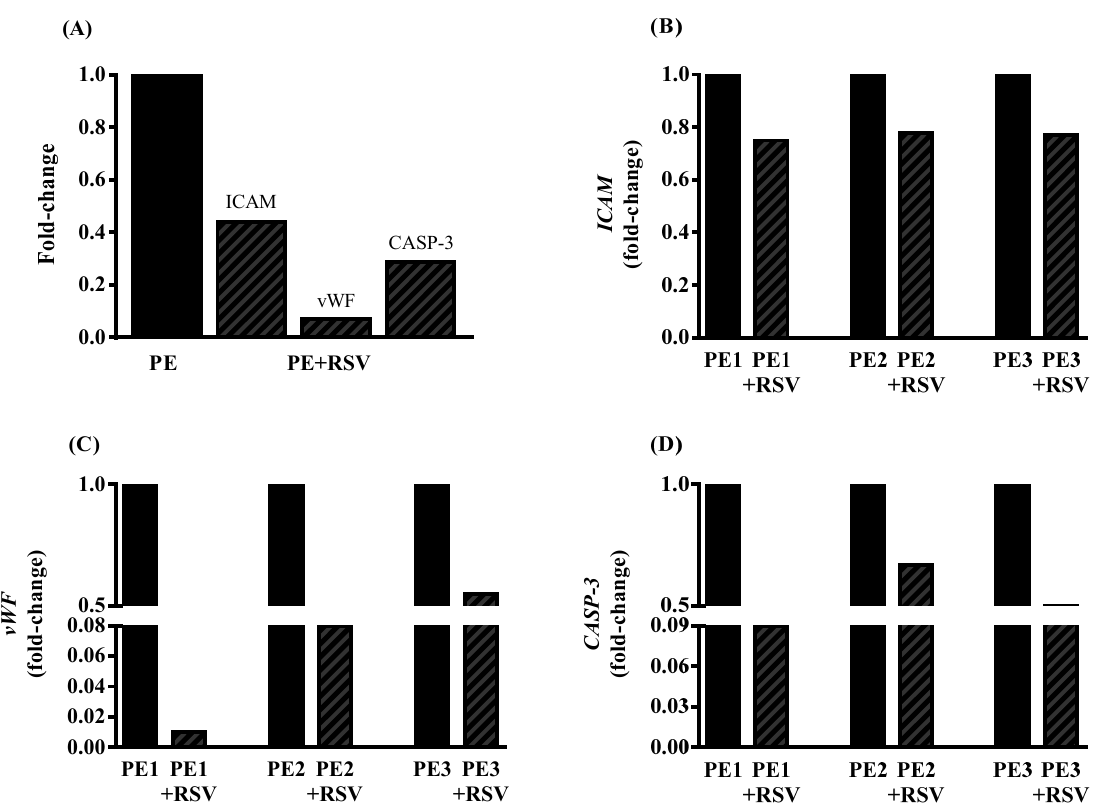
Figure 4. Fold change of ICAM-1 , vWF , and CASP-3 in all umbilical arteries tested ( A ), followed by independent gene expression in each preeclampsia pregnant individually ( B – D ). Umbilical arteries from PE patients were incubated with RSV (100 µ M) for 4 h. Values are presented as fold change. Fold change = 1 represents PE without treatment. p < 0.05 compared to PE without treatment.